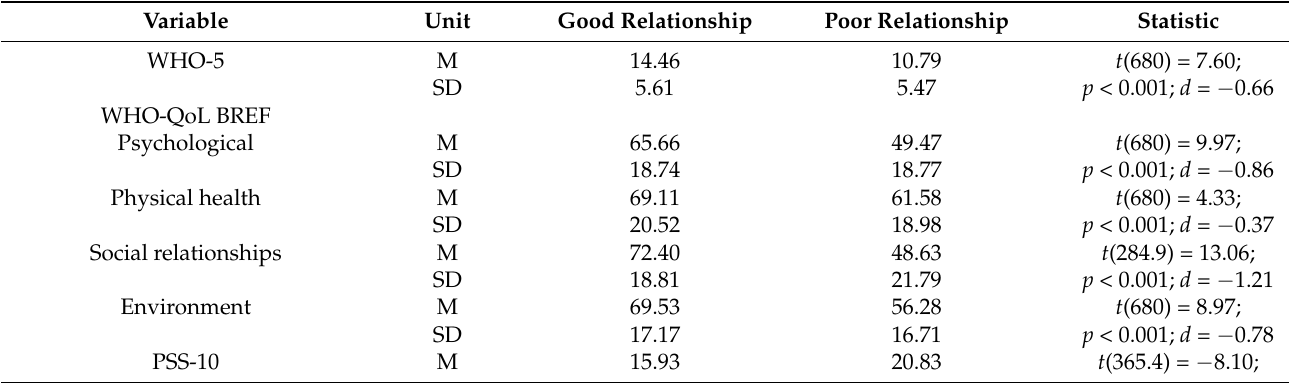
Table 2. Measures of well-being and mental health during the COVID-19 lockdown in individuals with good ( n = 500) or poor ( n = 182)